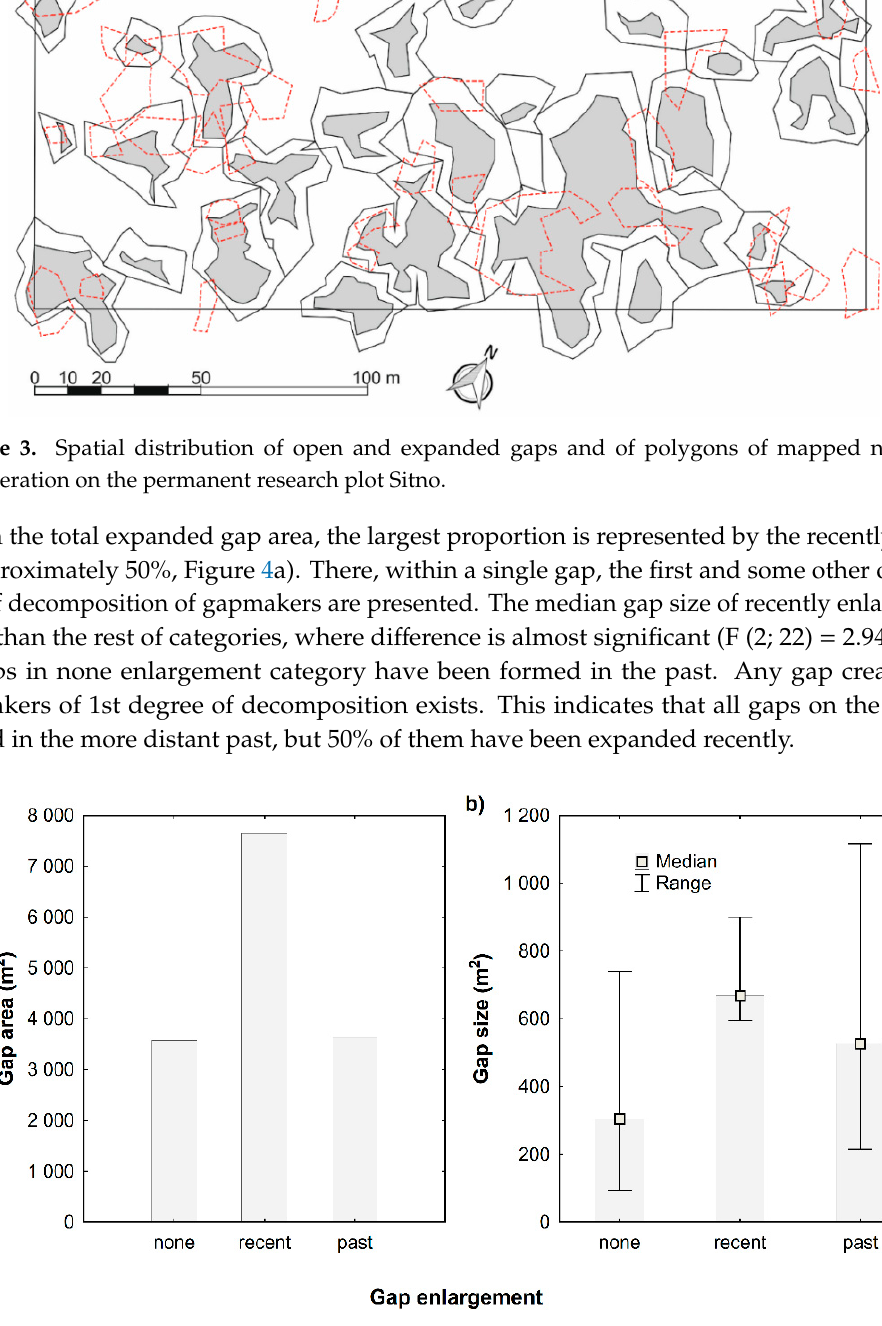
Figure 3. Spatial distribution of open and expanded gaps and of polygons of mapped natural regeneration on the permanent research plot Sitno.